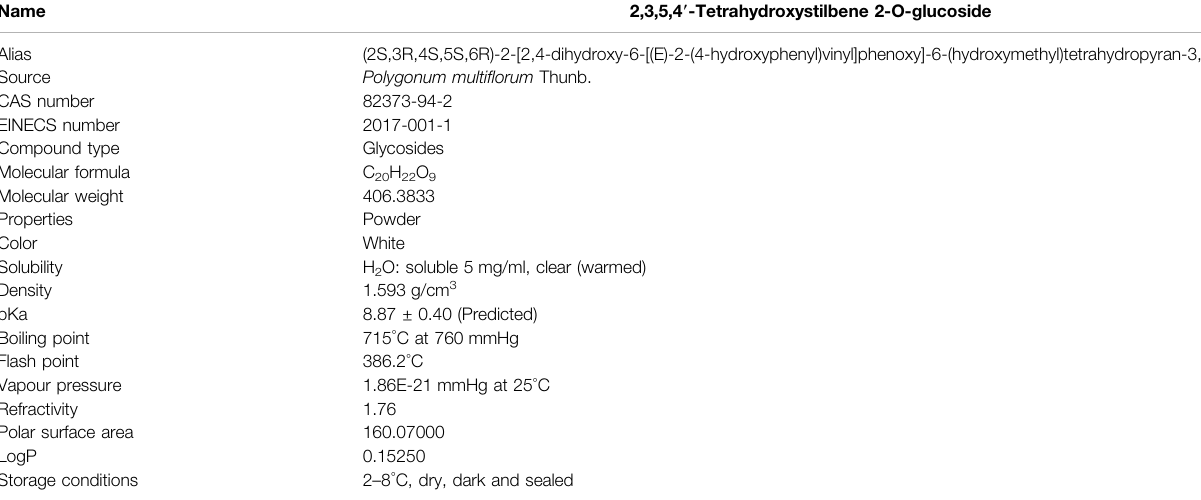
TABLE 1 | Physical and chemical properties of TSG.